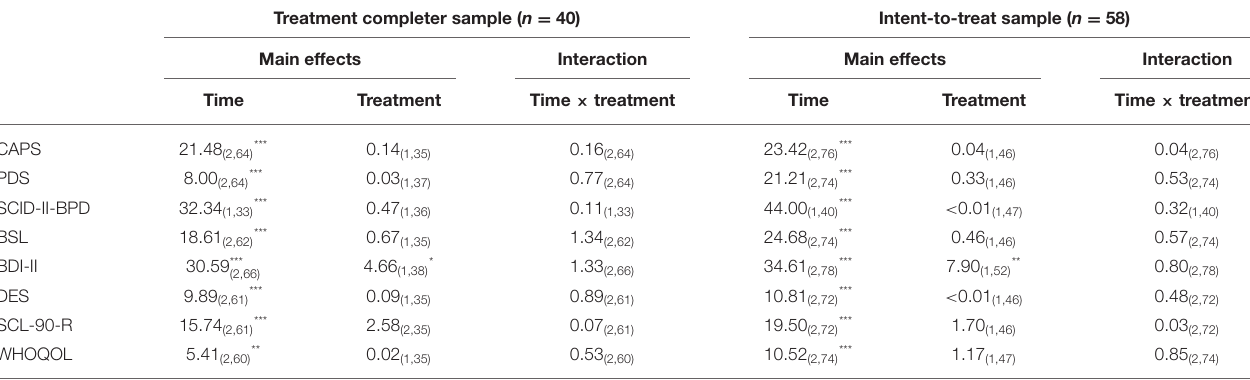
TABLE 2 | Results of mixed-effects models for all outcome